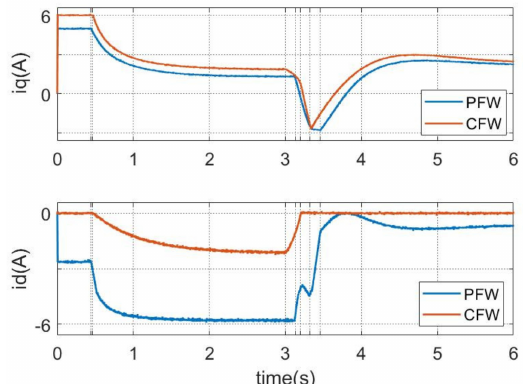
Figure 15. IPMSM dq-currents.